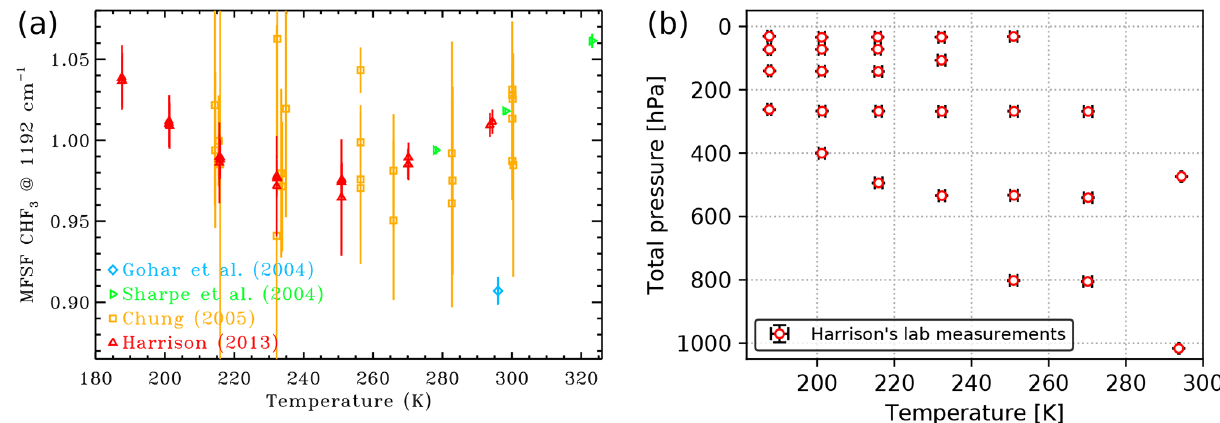
Figure 9. (a) Retrieved mole fraction scaling factors from four HFC-23 laboratory spectrum datasets using the 2020 HFC-23 PLL at the spectral region from 1105–1240cm − 1 plotted vs. temperature. (b) The temperature and pressure conditions of the laboratory measurements of Harrison (2013). Table 5. HFC-23 annual growth rates and standard errors derived from monthly mean X HFC-23 at Rikubetsu and Syowa Station, (pptyr − 1 ). The annual growth rates computed from the AGAGE annual global mean dataset, the CGAA air sample dataset, and the AGAGE in situ measurements at THD and CGO are also listed for the same periods unless indicated by other time frames in brackets. Observation site,